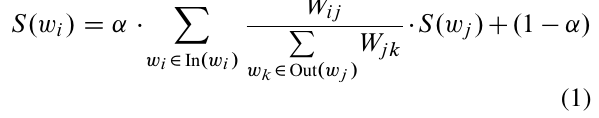
Algorithm 1 Keyword extraction